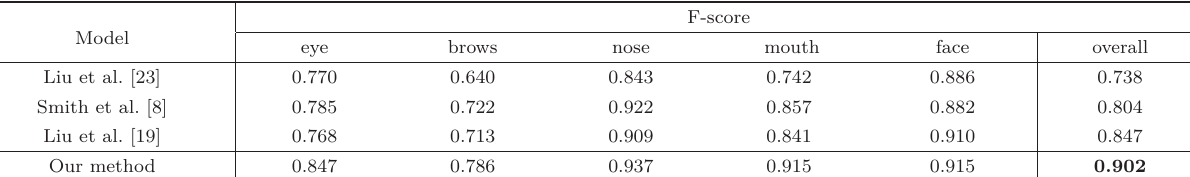
Table 5 Quantitative comparison of our method and other face parsing models on the face parsing task. Our method performs best